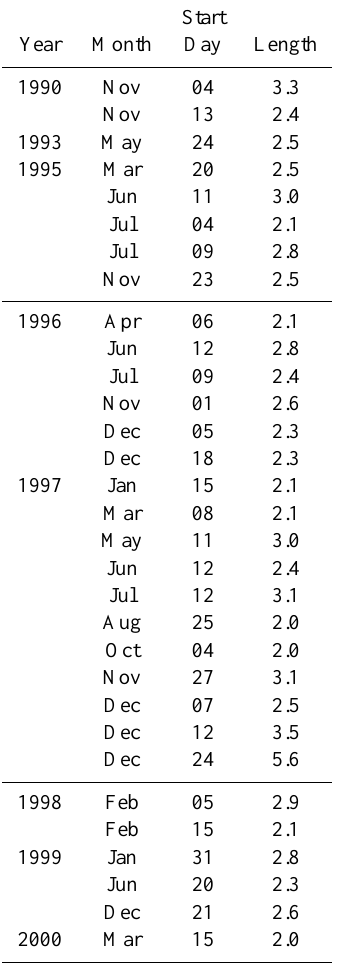
Table 2. The set of 31 periods that were “quiet” for at least